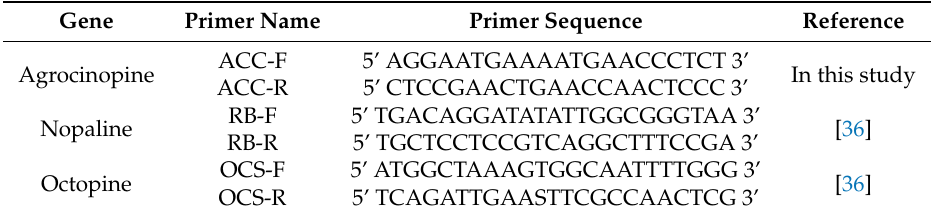
Table 1. List of primers used in this